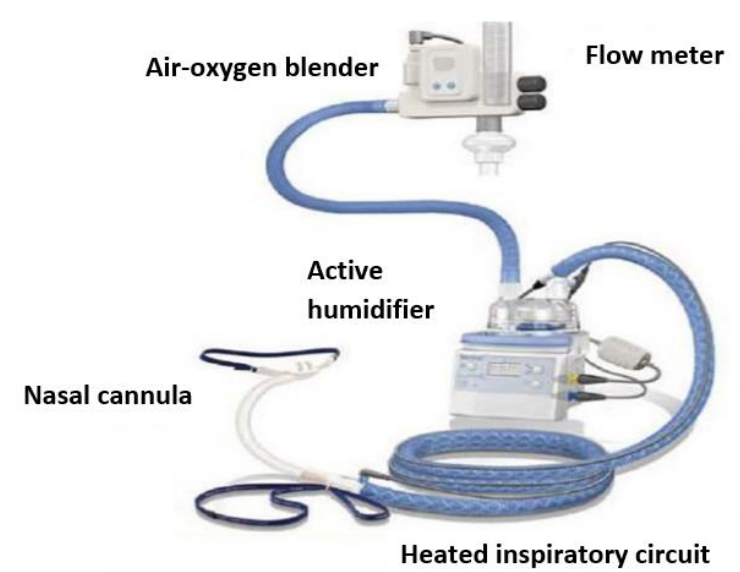
Figure 1. Optiflow nasal high-flow system (Fisher & Paykel Healthcare).